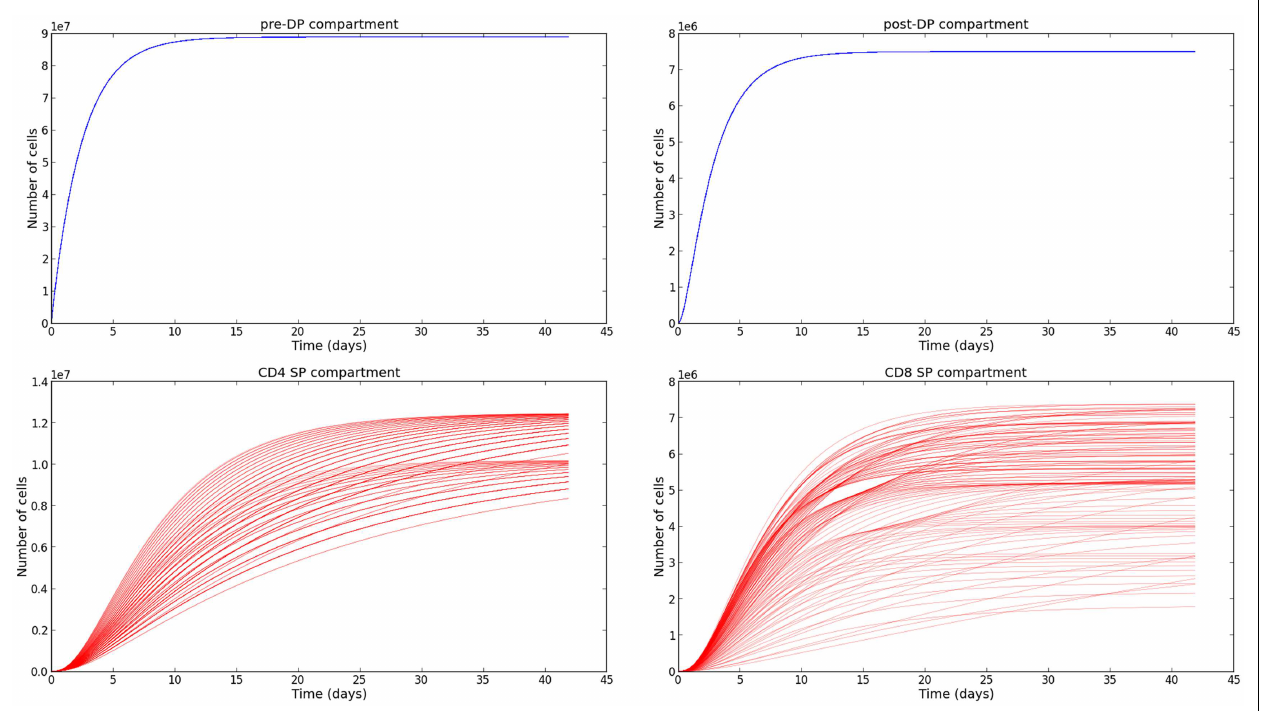
FIGURE 5 |Time evolution of the thymocyte populations in the second model .The different trajectories correspond to the parameter values and ranges described in Table 2 .